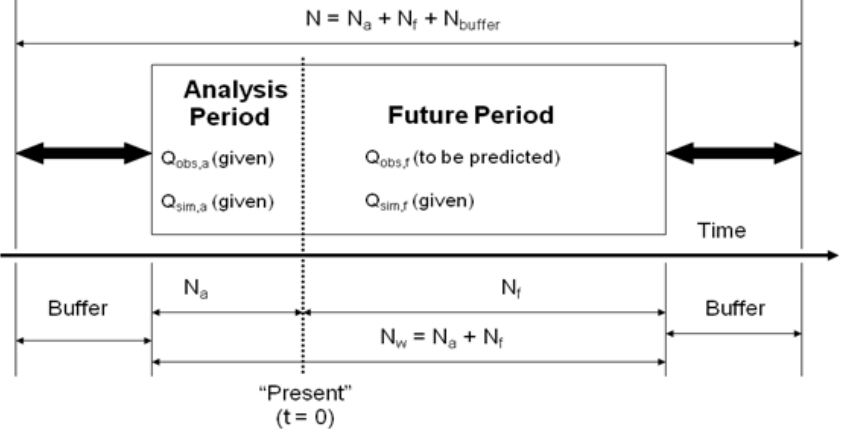
Fig. 2. The data window for the